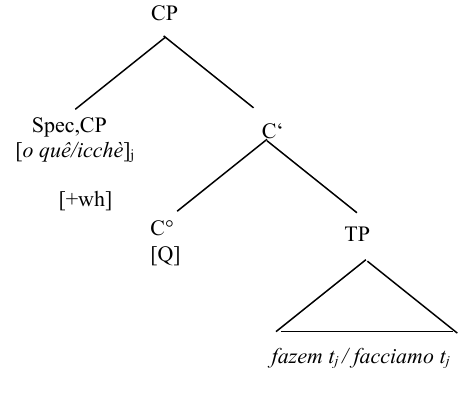
Figure 1 Q-SFRs in Portuguese and Florentine